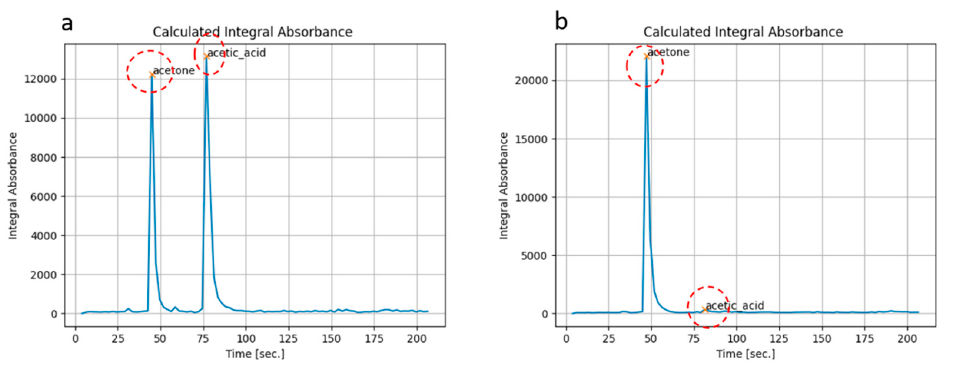
Figure 7. Total absorption chromatograms obtained by desorbing in air at 280 °C ( a ) or at 180 °C ( b ) vapors of acetone by means of the first-stage pre-concentrator, showing how high temperature could promote partial conversion of acetone into acetic acid.